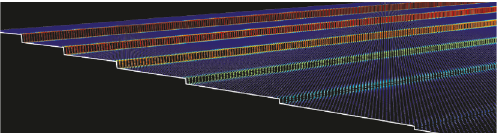
Figure 5: Curvatures of an artificial 3D point cloud with curbs of different heights: 3, 5, 7, 10, 12, and 15cm, respectively. Curvature values are represented in a color scale where cold colors correspond to low curvature values and warm colors correspond to high